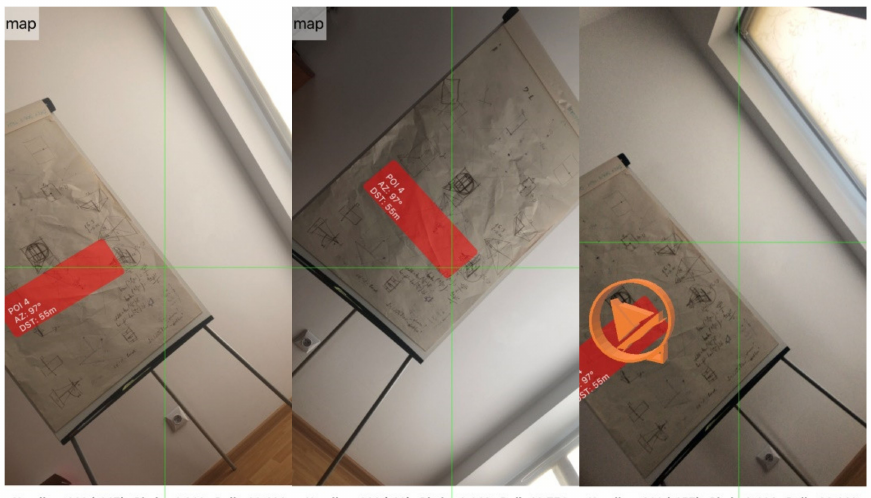
Figure 11. Test application presenting labels and 3D models of spatial objects based on sensor